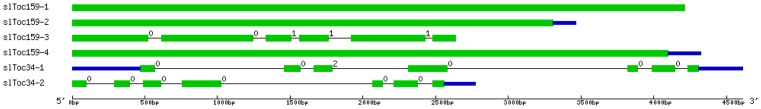
Exon-intron organization of tomato Toc GTPase genes.Exons and introns were predicted as described in the Materials and Methods. Exons are represented by green boxes, introns by black lines; blue lines correspond to the 5′ UTR and 3′UTR.